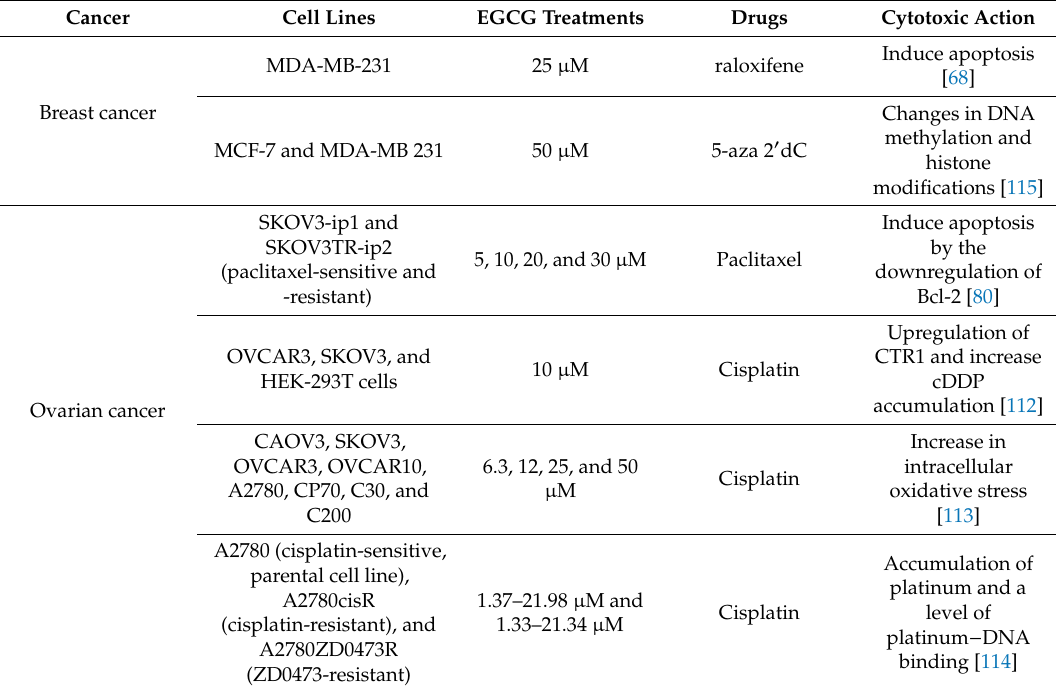
Table 3. Pharmaceutical synergistic e ff ects of